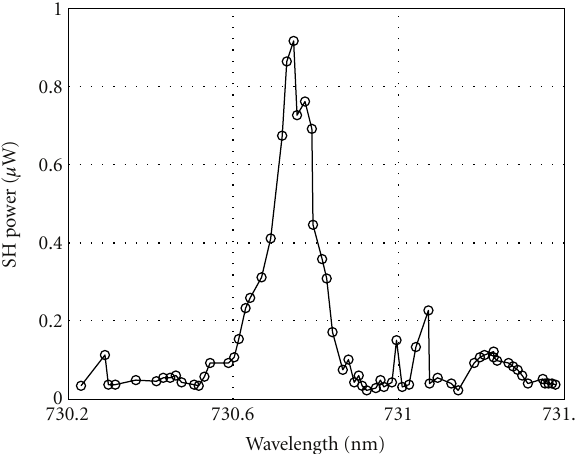
Figure 8: SH power generated in a 7 μ m wide channel versus FF input